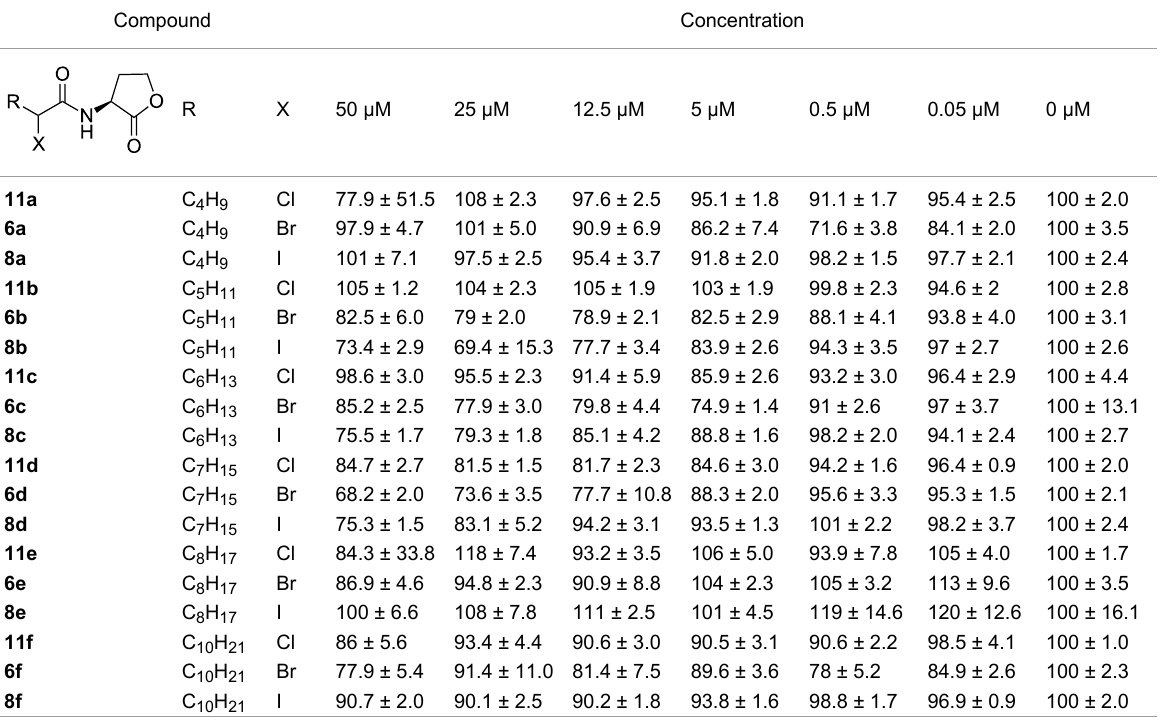
Table 2: Inhibition of QS regulated GFP production in the Escherichia coli JB 523 bioassay by α -haloacylated analogues 6 , 8 and 11 a . Compound